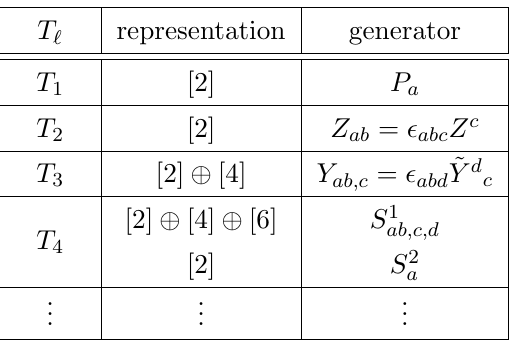
Table 1 . The free Lie algebra f ( P ) in D = 3 space-time dimensions. Representations are labelled by the complexi(cid:12)ed Lorentz algebra of type A 1 while the generators represent the associated so (1 ; 2) tensors. For mixed symmetry, these are reducible in the way described in footnote